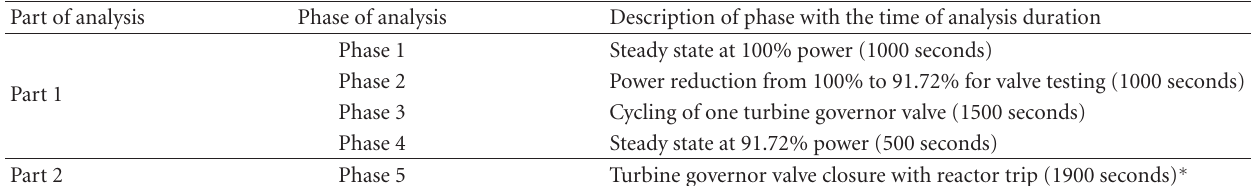
Table 1: Subdivision of